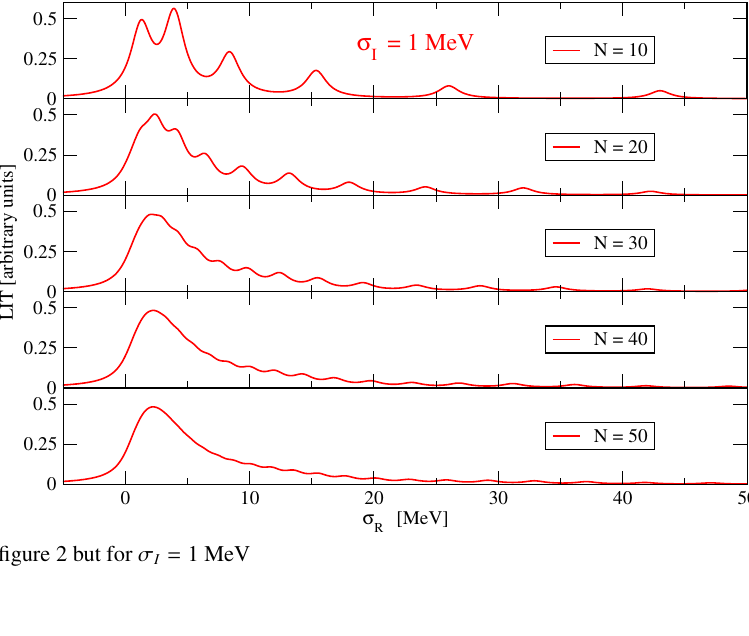
Figure 3. As (cid:2)gure 2 but for (cid:27) I = 1 MeV